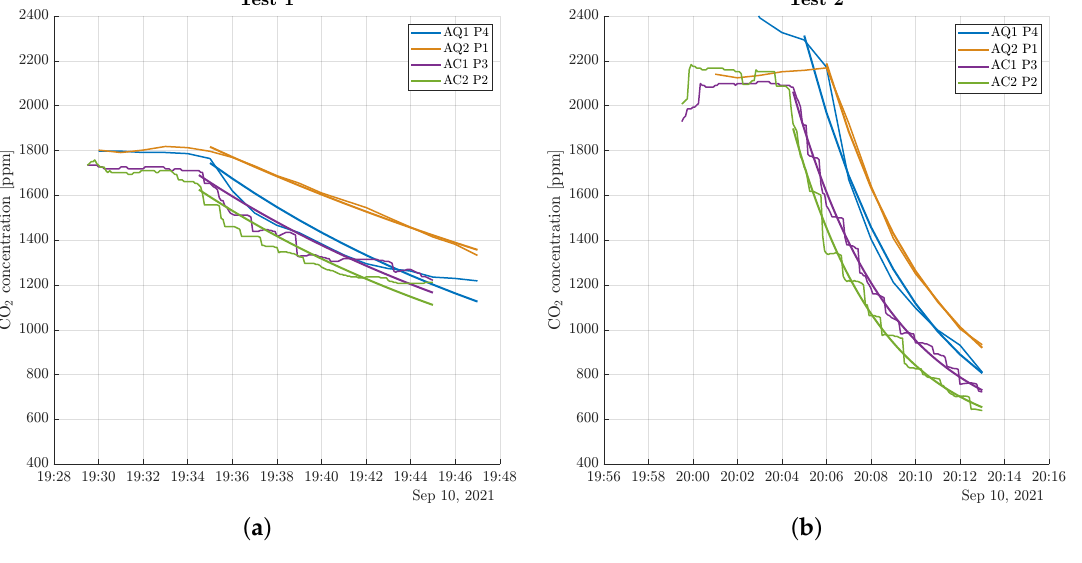
Figure 3. Example of results for controlled tests. ( a ) depicts test 1, with unilateral ventilation. ( b ) depicts test 2, with crossed ventilation. Each colour identifies a monitor at a specific measurement position. The jagged curves correspond to experimental data and the smooth curves represent the adjusted box model.